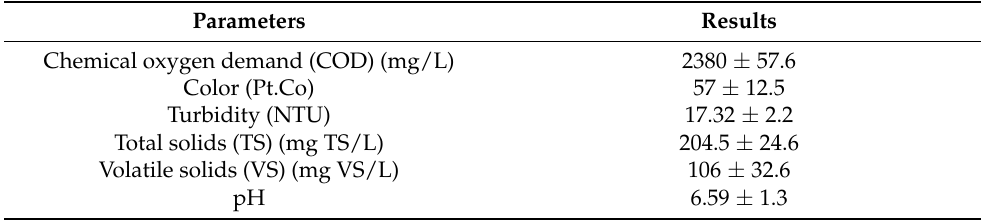
Table 2. Characteristics of wastewater and sludge